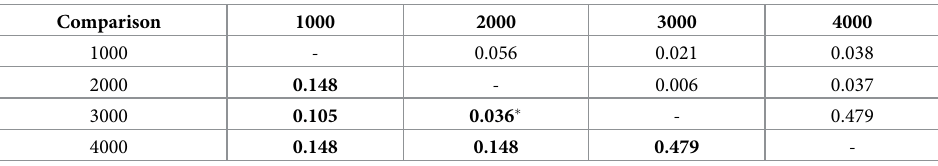
Table 2. P-values of pairwise PERMANOVA for each elevation level. Comparison 1000 2000 3000 4000 1000 - 0.056 0.021 0.038 2000 0.148 - 0.006 0.037 3000 0.105 0.036 � - 0.479 4000 0.148 0.148 0.479 - P-values after Holm Correction are shown in bold. Uncorrected P-values are in normal font. � = p <